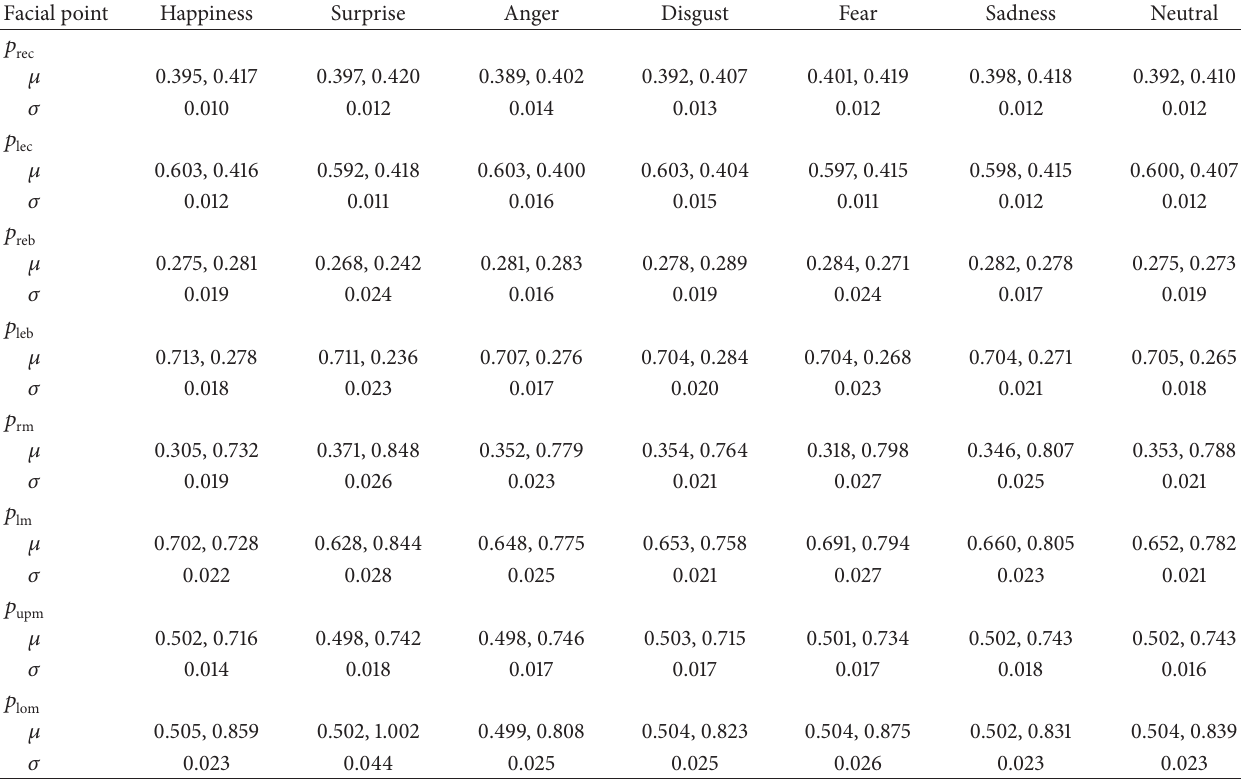
Table 1: The mean ( 𝜇 ) and standard deviation ( 𝜎 ) of the facial point ( 𝑃 𝑠 ) position for the six basic facial expressions, plus neutral expression (based on CK+ database). 𝜎 is square root of the average sum of the squared standard deviations in 𝑥 - and 𝑦 -coordinates. Each point is positioned inside a detected face of normalized size of 1 ∗ 1 , where the upper left corner is the origin. Facial point Happiness Surprise Anger Disgust Fear Sadness Neutral 𝑝 rec 𝜇 0.395,